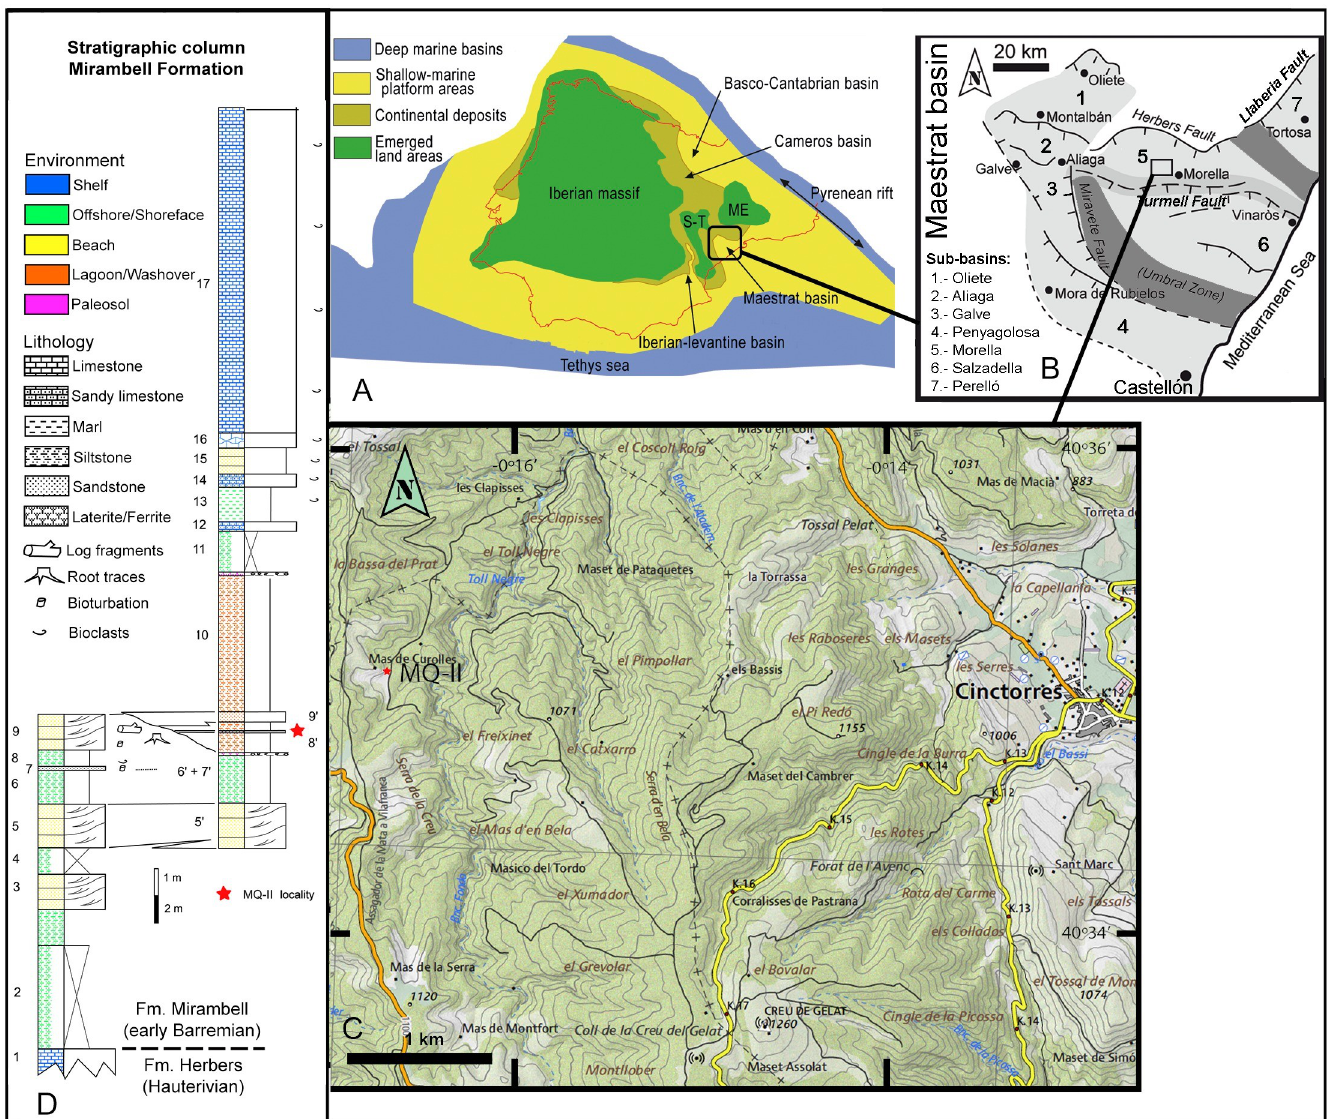
Fig 1. Geographical and geological location of the MQ-II fossil locality in Portell (Castello´n, Spain). (A) Palaeogeographic basins of the Iberian Plate during Early Cretaceous, modified from Santos-Cubedo et al. [14] under a CC BY license, with permission from Loisele Ediciones, original copyright [2016]. (B) Palaeogeographic sub-basins within the Maestrat Basin and active faults during Early Cretaceous sedimentation, modified from Fig 1A in Holgado et al. [15] under a CC BY license 4.0. (C) Geographical location of the MQ-II site. Base map from CV50 2019 CC BY 4.0 © Institut Cartogr à fic Valenci à , Generalitat. (D) Stratigraphic column for the Mirambell Formation in the MQ-II